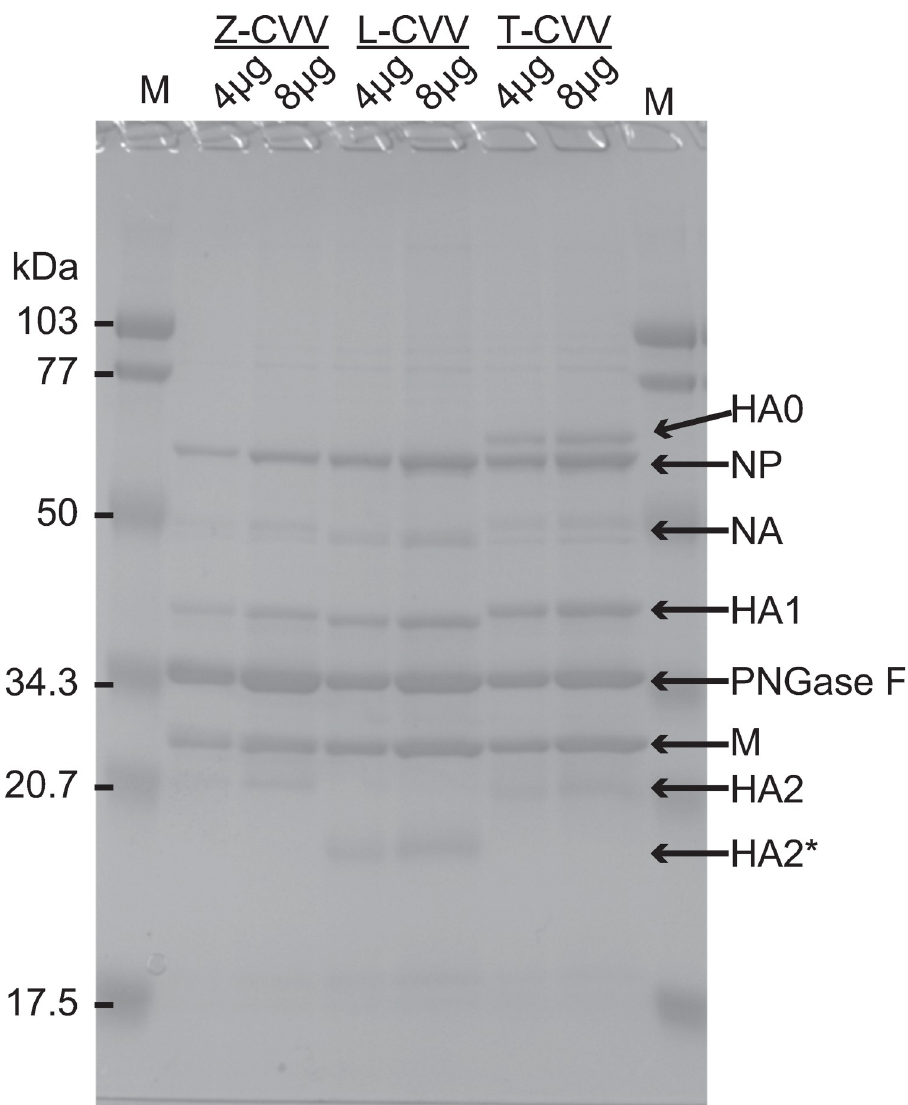
Fig 2. SDS–PAGE analysis of viral concentrates of CVVs. SDS–PAGE analysis of Z-CVV, L-CVV, and T-CVV. HA2 � represents an HA2 with slower mobility than that of other CVVs. M indicates size